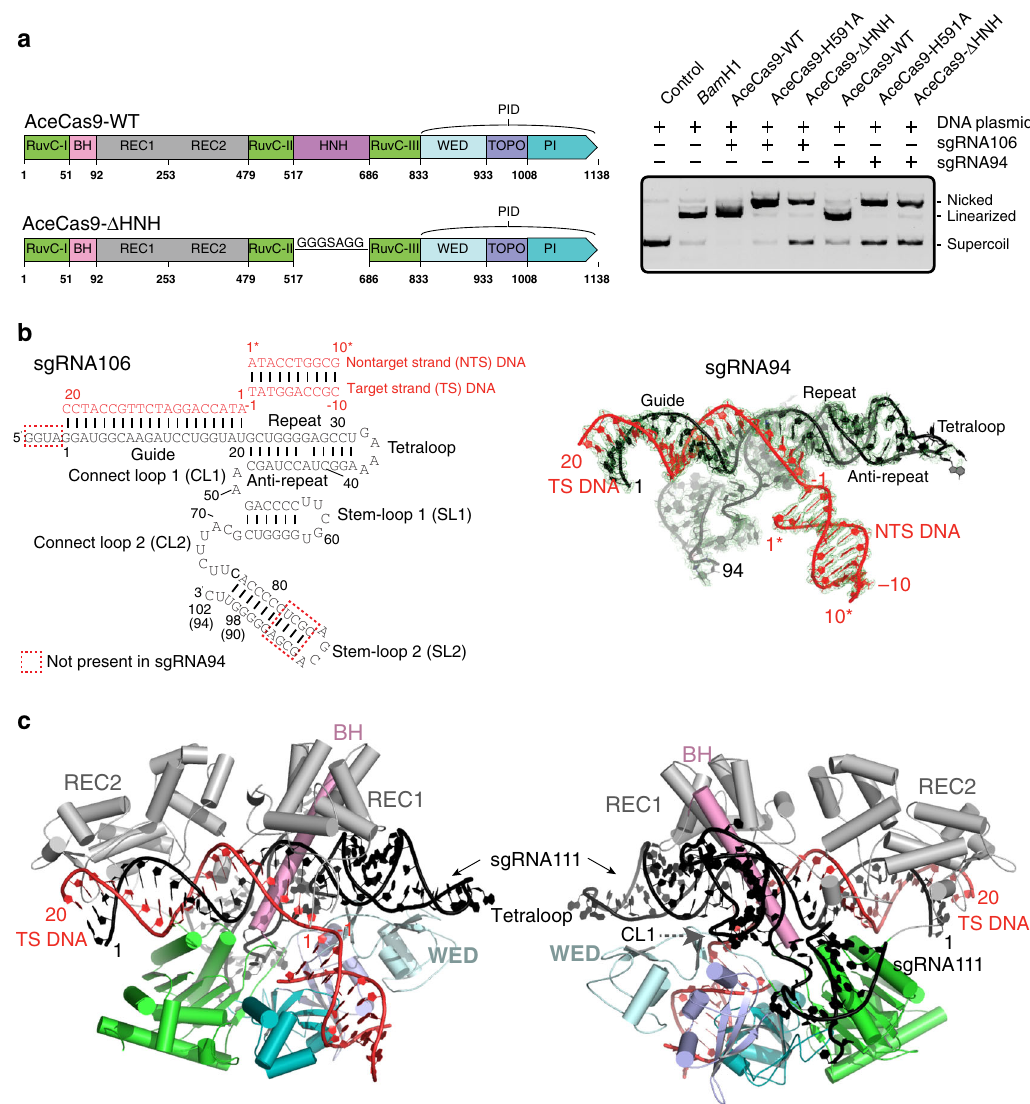
Fig. 2 Overview of crystal structure of AceCas9 – Δ HNH – sgRNA – DNA complex. a Left: Primary structural features of AceCas9 and AceCas9 – Δ HNH. BH, bridge helix (or arginine-rich helix), RuvC-I/RuvC-II/RuvC-III, RuvC domain, REC1/REC2, nucleic acid recognition domains 1 and 2, WED, wedge subdomain, TOPO, Topo-homology subdomain, PI, PAM-interacting subdomain. Right: DNA cleavage activity of AceCas9 – Δ HNH with two single-guide RNA (sgRNA106 and sgRNA94). The cleavage experiment has been repeated more than three times with similar results. b Left: Secondary structure of the single-guide RNA, sgRNA106 and sgRNA94 (black), and their relationship with the DNA oligos (red) used in co-crystallization. Boxed nucleotides are present in sgRNA106 but not in sgRNA94. The nucleotide numbering is shown for both sgRNA106 and sgRNA94 except those in parentheses are for sgRNA94. Right: The omitted 2F o – F c electron density contoured at 2.0 σ around all nucleic acid components of the complex using the fi nal re fi ned ternary complex structure for phases and observed structural factors for amplitudes. The sgRNA94 is colored in black and the DNA is in red. c The structure of the AceCas9e – sgRNA94 – DNA in a front and a back view. Domains and the nucleic acids are colored as in ( a ) and throughout the article. The DNA cleavage experiments shown in panels ( a ) have been repeated more than three times with similar results. Source data are provided as a Source data fi nucleotides including the fi rst triphosphate nucleotide (G1), and